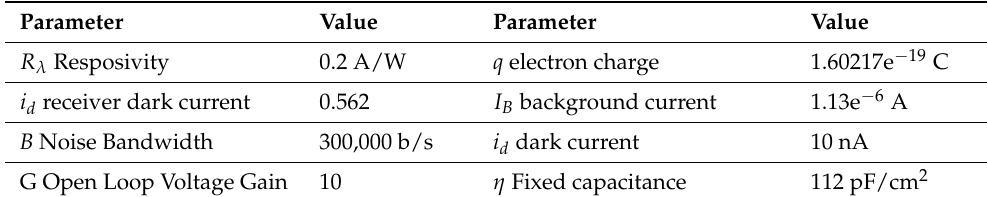
Table 1. Parameters for the SNR